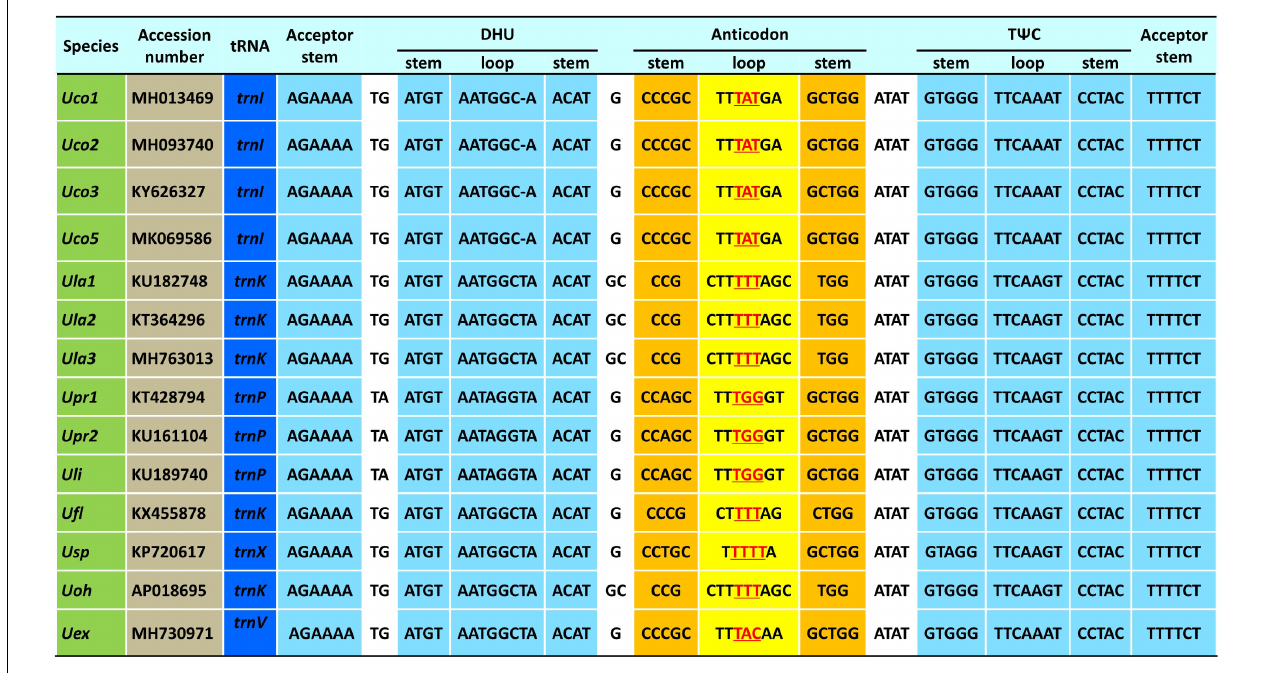
FIGURE 4 | The aligned sequences of tRNA genes located between cox3 and rpl14 in the 14 Ulva mitogenomes.